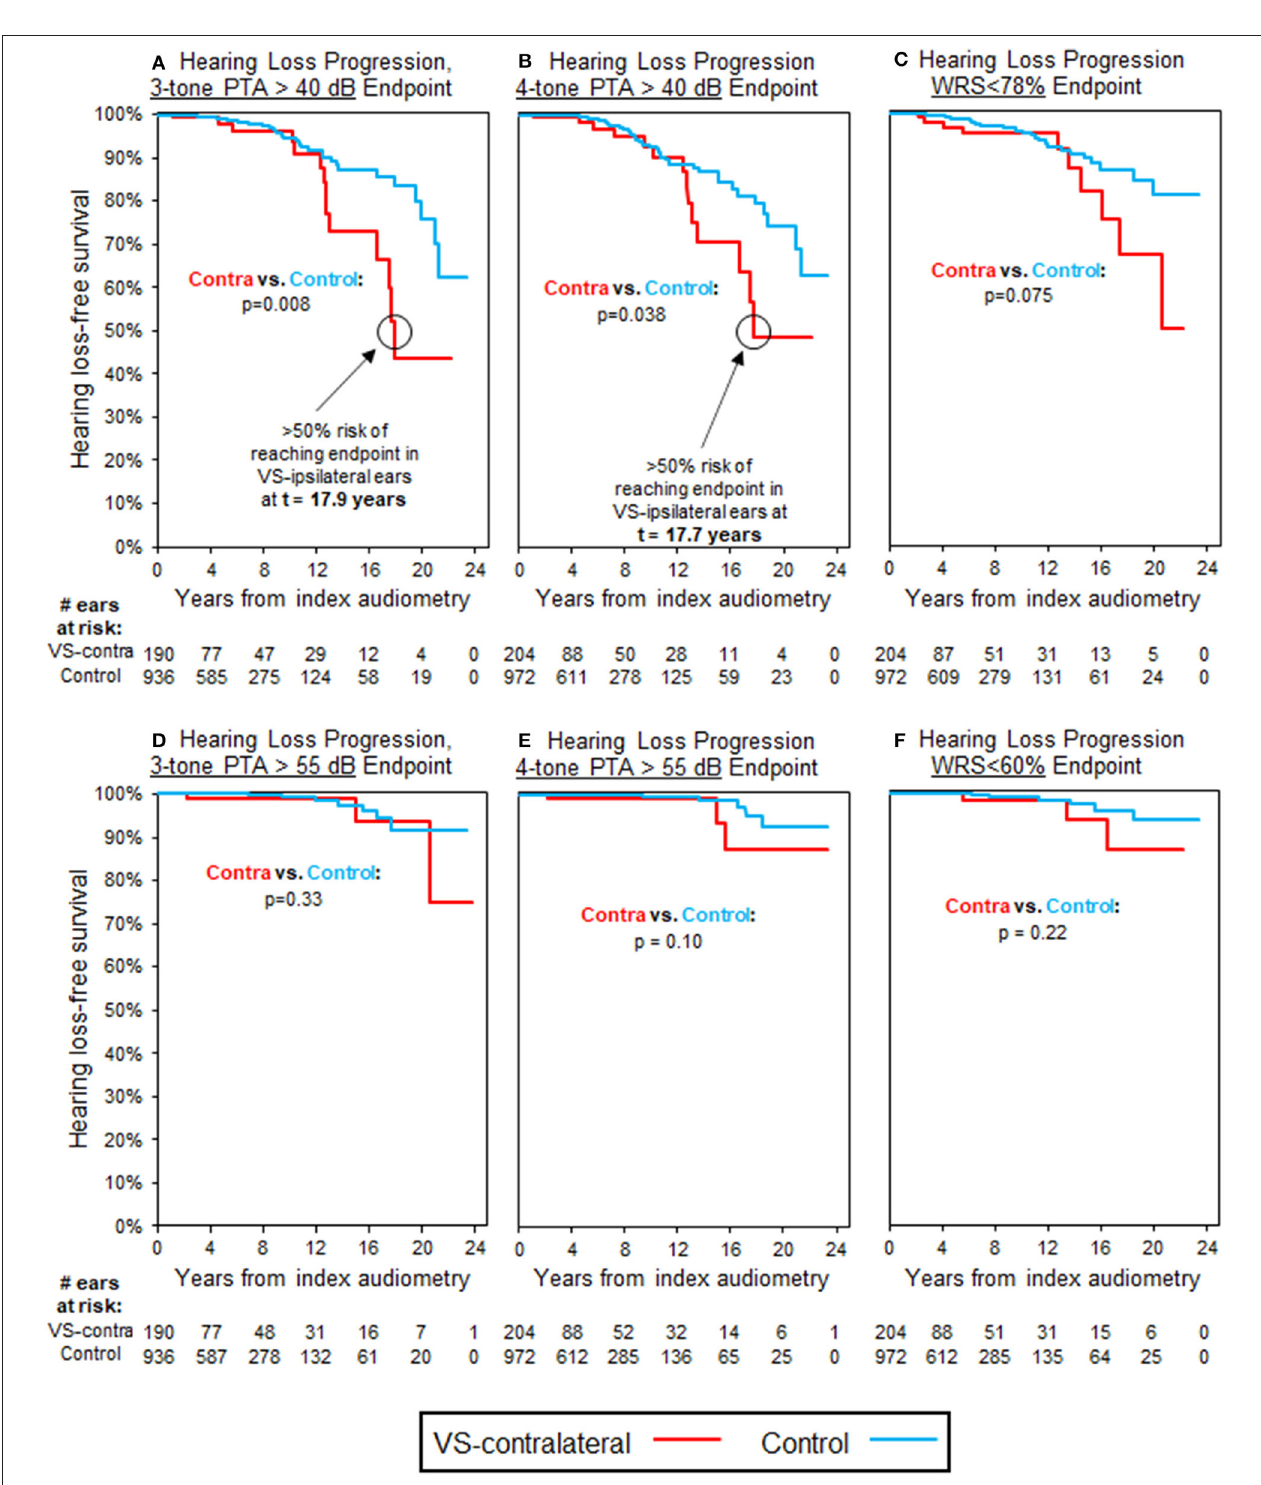
FIGURE 3 | Kaplan-Meier curves for HL progression in patients with baseline abnormal hearing in VS-ipsilateral ear (WRS < 92% and PTA > 25 dB) and baseline normal hearing in VS-contralateral ear (WRS ≥ 92% and PTA ≤ 25 dB); see Table 3 for demographics. Analysis uses three-tone PTA to assess baseline hearing in (A,D) , as well as endpoint in (A) , while four-tone PTA used, respectively in (B,C,E,F) . (A) Endpoint bone three-tone PTA > 40 dB (moderate HL); (B) Endpoint bone four-tone PTA > 40 dB (moderate HL); (C) Endpoint word understanding < 78%; (D) Endpoint bone three-tone PTA > 55 dB (moderately severe HL); (E) Endpoint bone four-tone PTA > 55 dB (moderately severe HL); (F) Endpoint word understanding < 60%. All control ears with normal baseline hearing defined by same criteria as for VS-ipsilateral and contralateral ears.